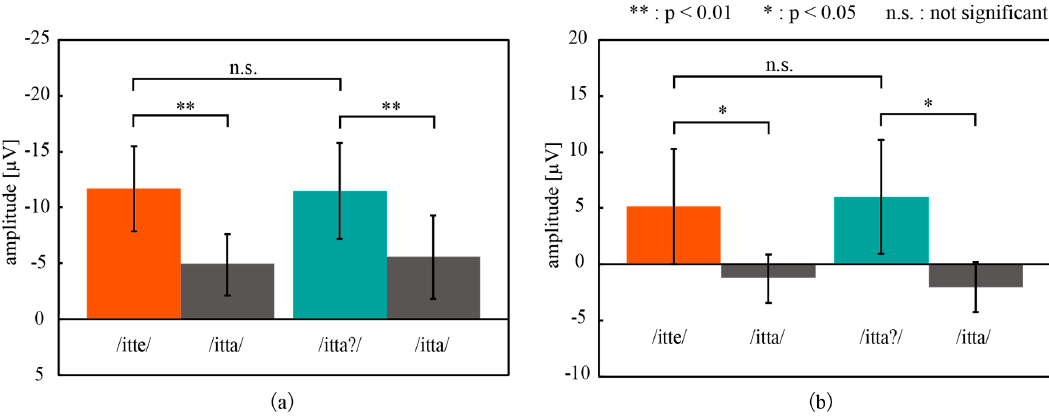
Figure 10. ( a ) MMN and ( b ) P300 obtained in the oddball task consisting of three speech sounds. /itte/ and /itta?/ represent the deviant stimuli, and /itta/ is the standard stimulus. Error bars: the standard